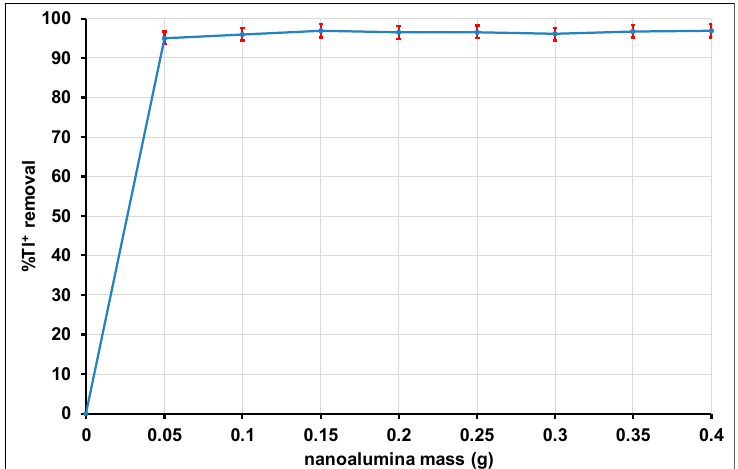
Figure 12. Effect of the adsorbent dose on the adsorption of Tl(I).